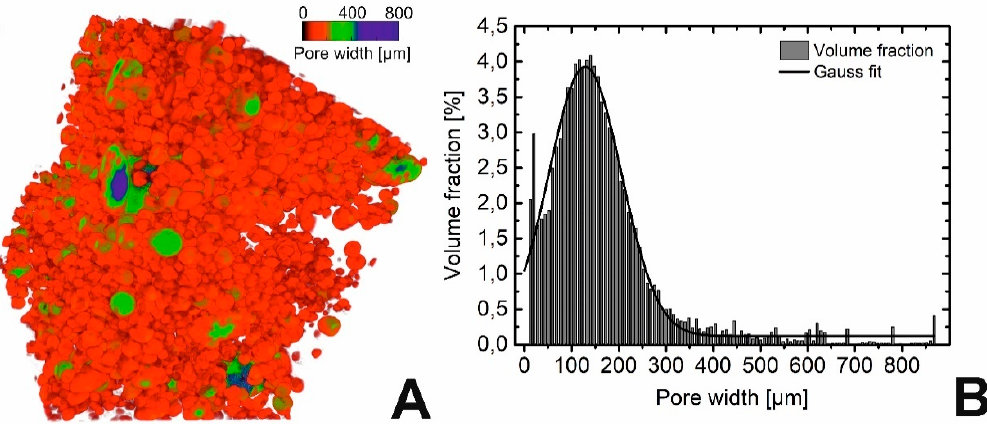
Figure 3. µCT image of PEUU foam after soaking in 1–octanol ( A ), closed cells are colored depending on their diameter) and its evaluation to illustrate the corresponding cell size distribution ( B ).